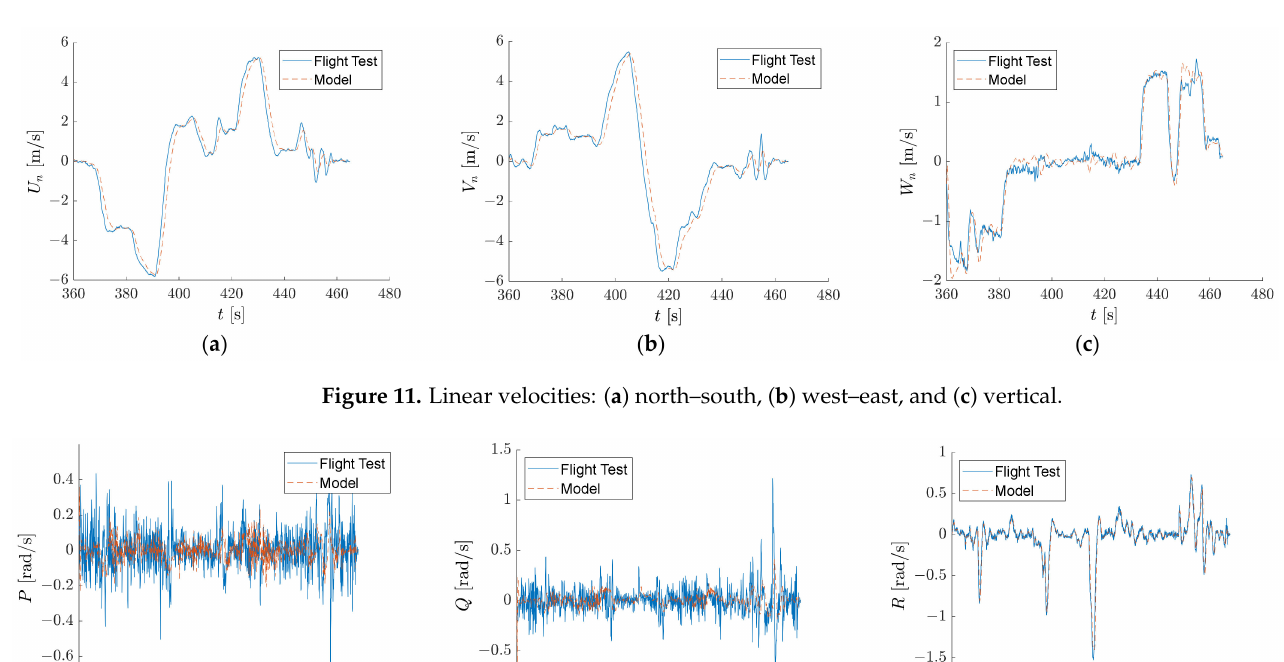
Figure 10. The comparison between the real and simulated trajectories: ( a ) 3D view of the trajectory and ( b ) 2D plot of the drone trajectory.